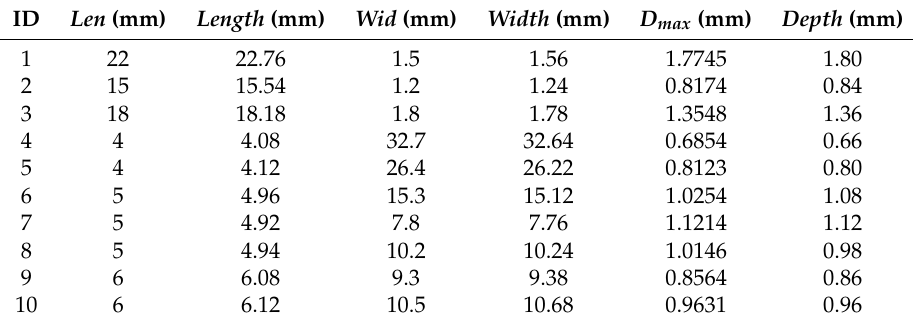
Table 3. Result of rail surface defect